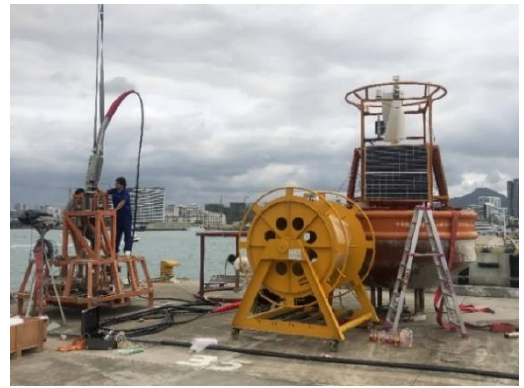
Figure 21. System testing and installation at the wharf.